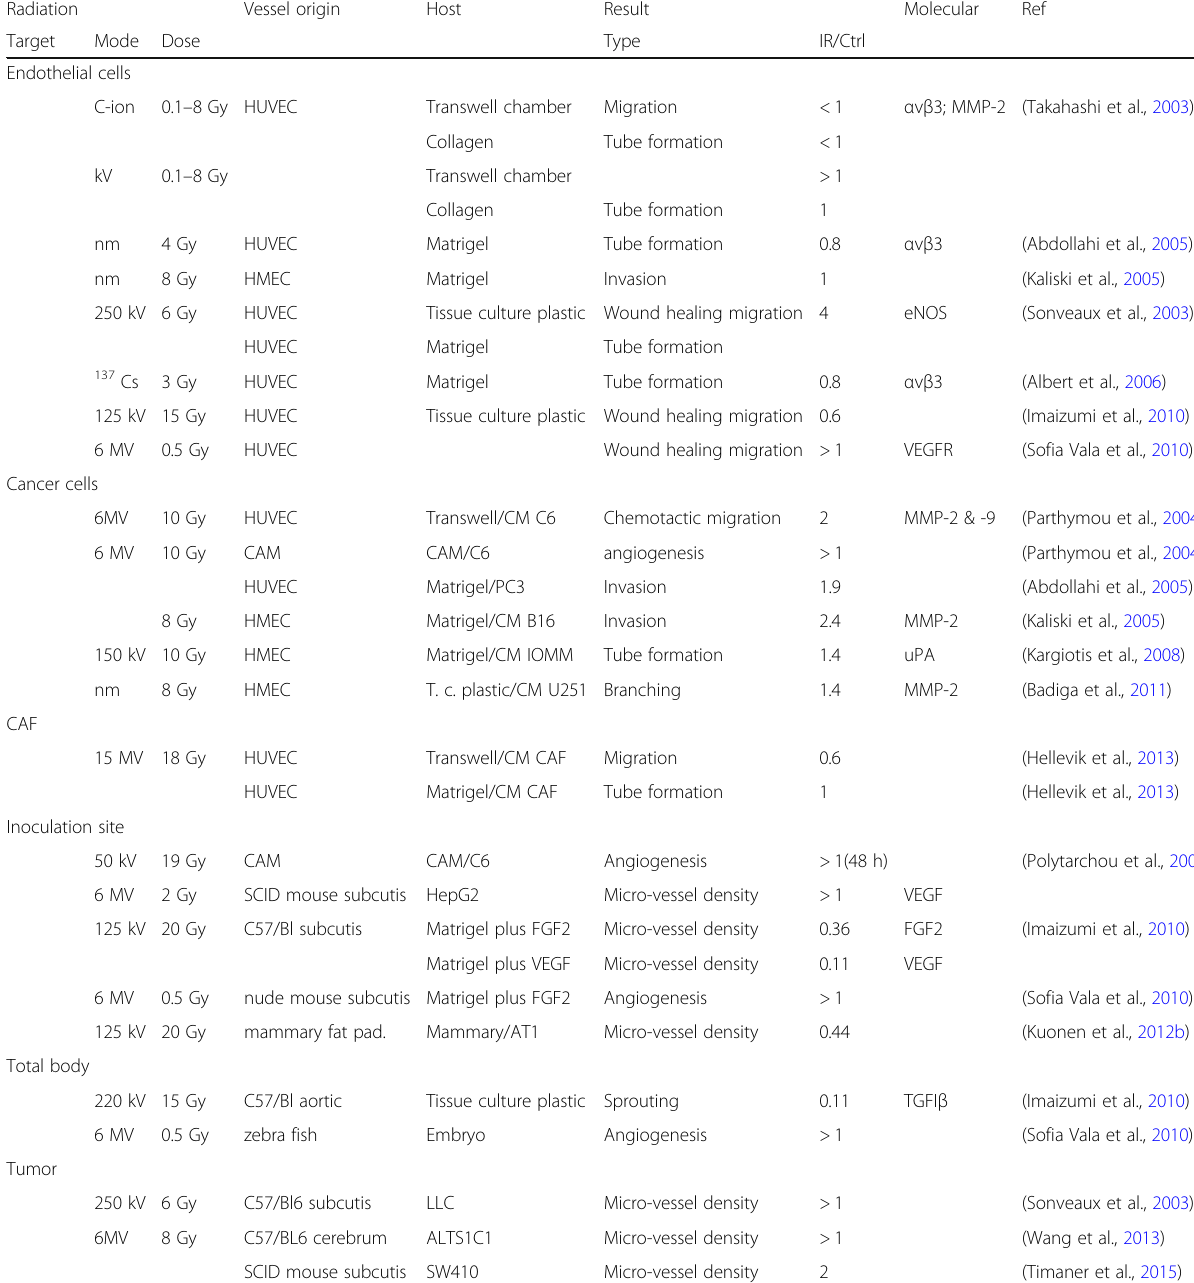
Table 1 In vitro and in vivo experiments investigating the influence of irradiation on angiogenesis